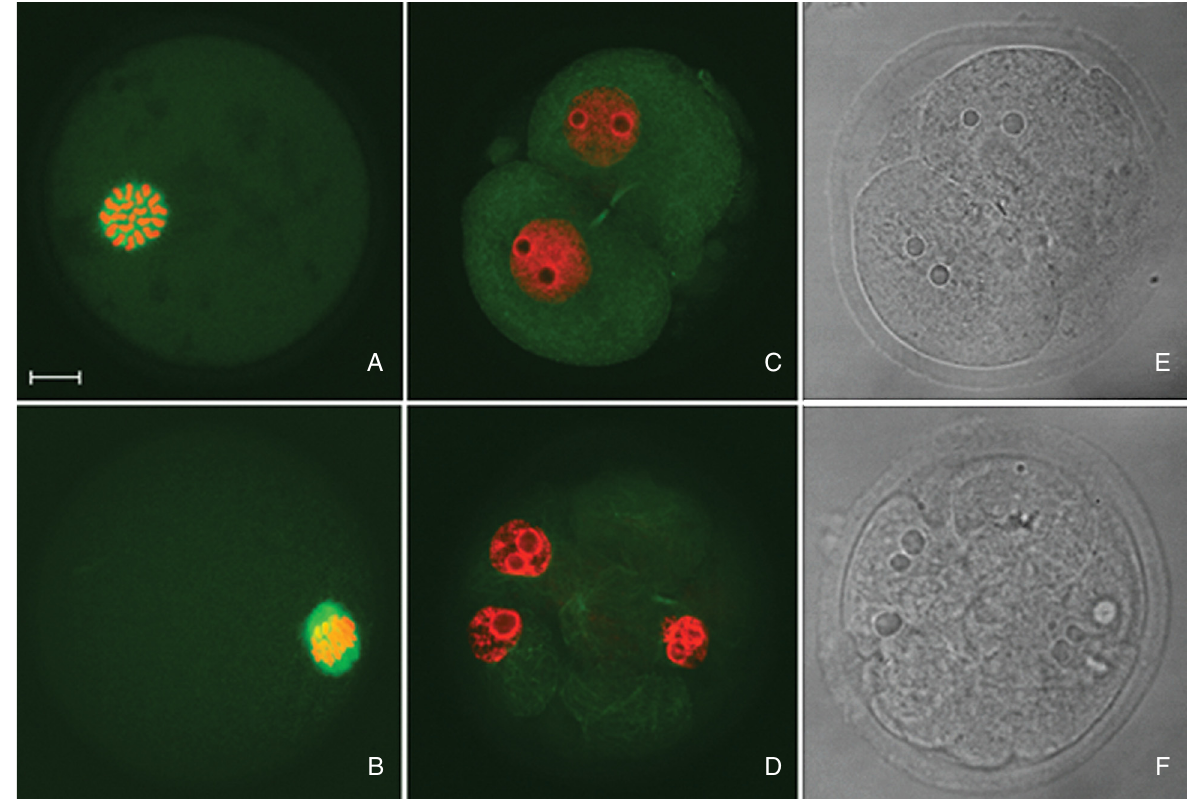
Figure 3. Development of the parthenogenetic embryos. Microtubules (green) and chromatin (red) were stained with anti-tubulin antibodies and propidium iodide, respectively. At 4 to 6 h, the activated oocytes entered mitosis. A, Oocyte at prometaphase. B, Oocyte at mitosis metaphase. C and E, At 24 h, activated oocytes formed a 2-cell embryo after 4 h of cytochalasin B treatment. D and F, At 24 h, activated oocytes without cytochalasin B treatment formed a 3-cell embryo with cytokinesis. Bar = 20 μ m for all